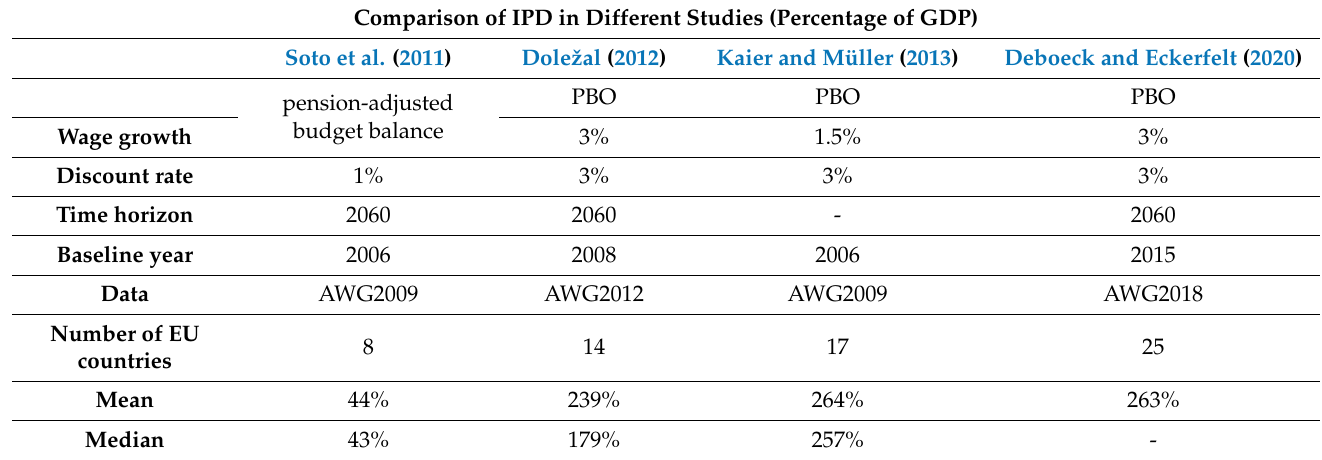
Table 7. Compilation of IPD estimates from previous studies using AWG data. Comparison of IPD in Different Studies (Percentage of